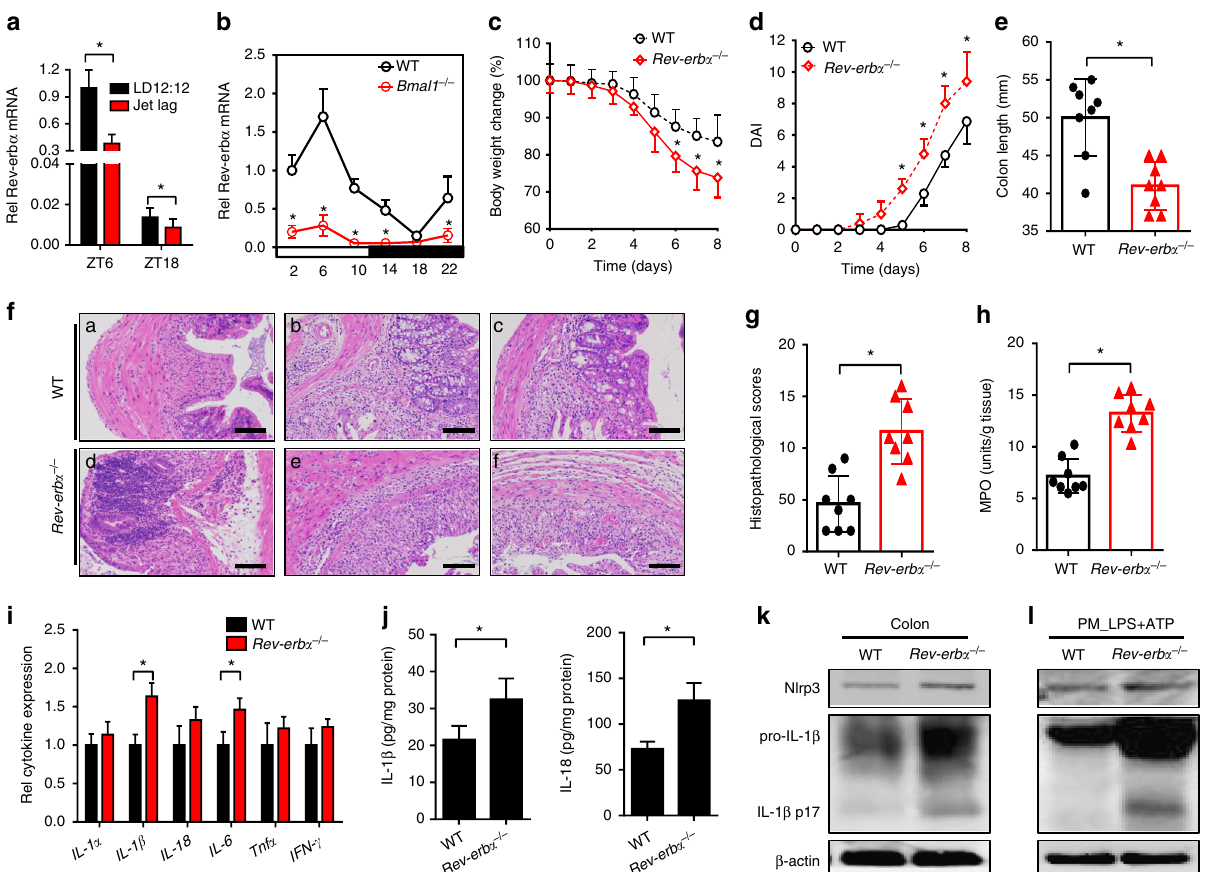
Fig. 2 Rev-erb α ablation sensitizes mice to experimental colitis. a Circadian clock disruption by jet lag decreased Rev-erb α . Data are mean ± SD ( n = 8). * P < 0.05 ( t test). b Circadian clock disruption by Bmal1 deletion decreased Rev-erb α . c Weight loss measurements of wild-type (WT) and Rev-erb α − / − mice treated with DSS. d DAI scores of wild-type and Rev-erb α − / − mice treated with DSS. In panels b – d , data are mean ± SD ( n = 8). * P < 0.05 versus WT at individual time points ( t test). e Colon lengths of wild-type and Rev-erb α − / − mice treated with DSS. Colon length was assessed at the time of necropsy. f Representative micrographs of H&E staining in the colon. Scale bar = 100 µ m. g Histopathological scores of wild-type and Rev-erb α − / − mice treated with DSS. h MPO activities of wild-type and Rev-erb α − / − mice treated with DSS on day 8. i Expressions of in fl ammatory cytokines in colons of WT and Rev-erb α − / − mice (2 days post DSS feeding) quanti fi ed by ELISA. Data are mean ± SD ( n = 6). * P < 0.05 ( t test). j ELISA measurements of colonic IL-1 β or IL-18 on day 8 after DSS feeding. k Western blotting of Nlrp3, IL-1 β , and β -actin in colons from WT and Rev-erb α − / − mice on day 8 after DSS feeding. l Western blotting of Nlrp3, IL-1 β , and β -actin in PMs from WT and Rev-erb α − / − mice. PMs were stimulated with LPS for 8 h and ATP for the last 0.5 h. Each western blot is representative of three independent experiments (statistical differences between blot density levels were analyzed by Mann – Whitney U test, Supplementary Figure 12). For biochemical analyses, mice were sacri fi ced at ZT8 and colons were collected. In panels e , g , h and j , data are mean ± SD ( n = 8). * P < 0.05 ( t test). DAI: disease activity index, MPO: myeloperoxidase. Chemical concentrations: LPS (100 ng/ml), ATP (2